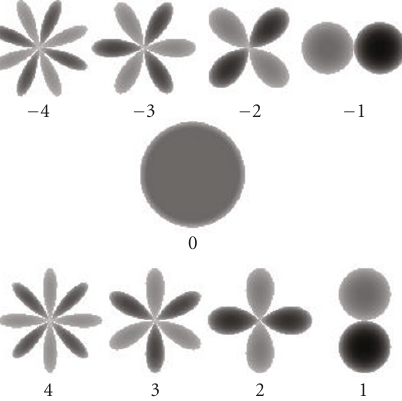
Figure 2: Elementary directivity functions, sources of degree − 4 to